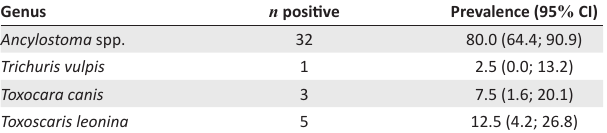
TABLE 3: Prevalence (with confidence intervals) of serum antibodies against infectious agents in dogs in Lilongwe, Malawi, September–October 2014. Type of dog Anaplasma spp. Ehrlichia spp.